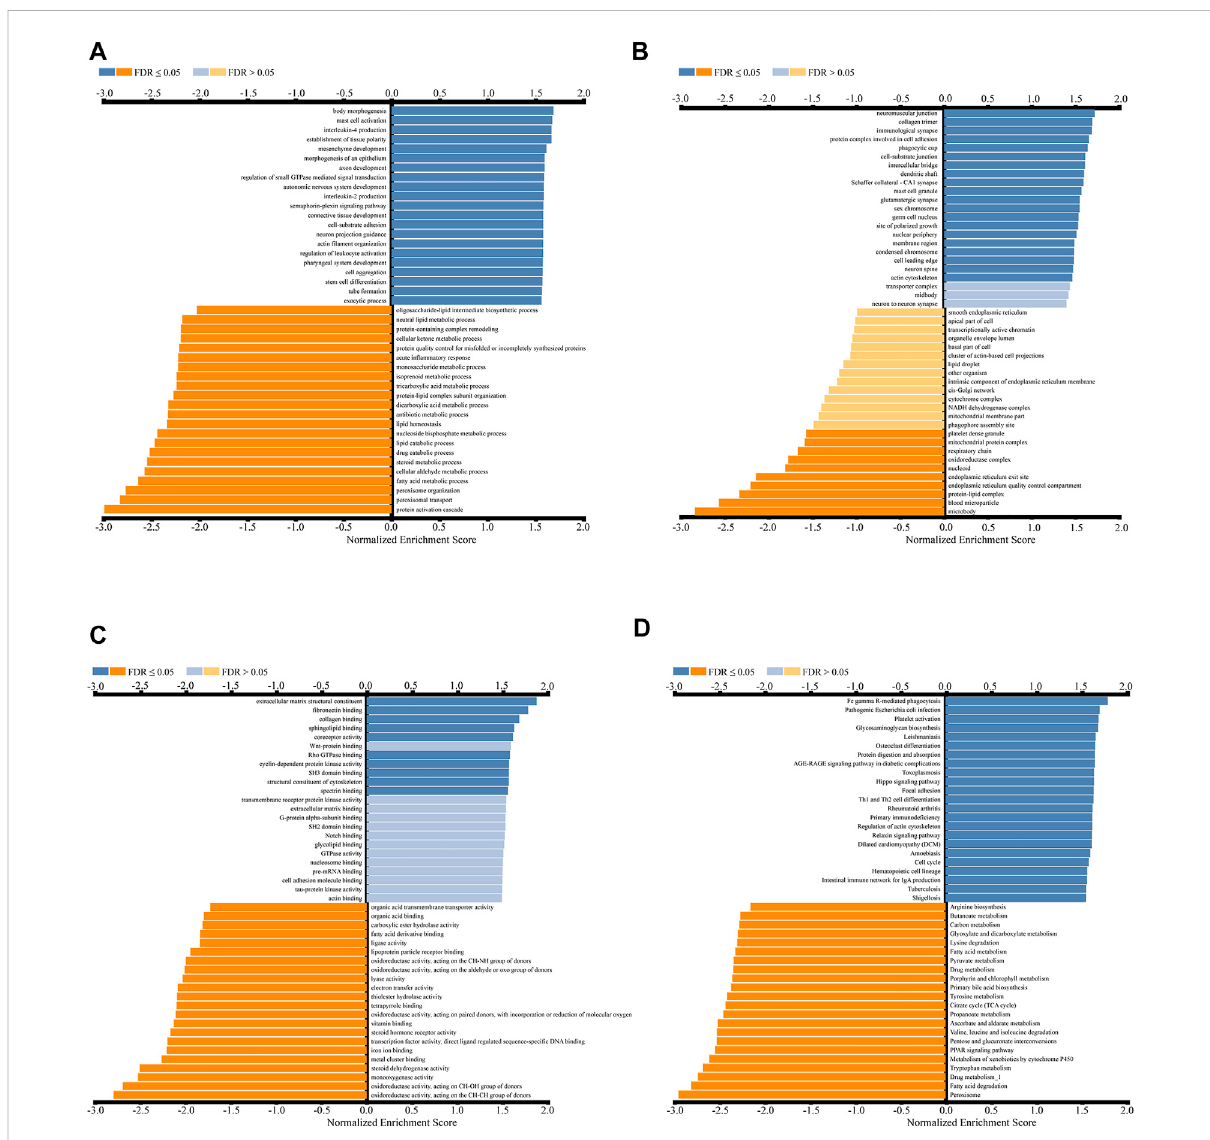
FIGURE 6 Enrichment analysis results of CDK2AP1 -related genes in LIHC cohort (A – C) GO gene enrichment analysis diagram of CDK2AP1 -related genes with biological processes (A) , cellular components (B) and molecular functions (C) categories (D) KEGG enrichment analysis diagram of CDK2AP1 - related